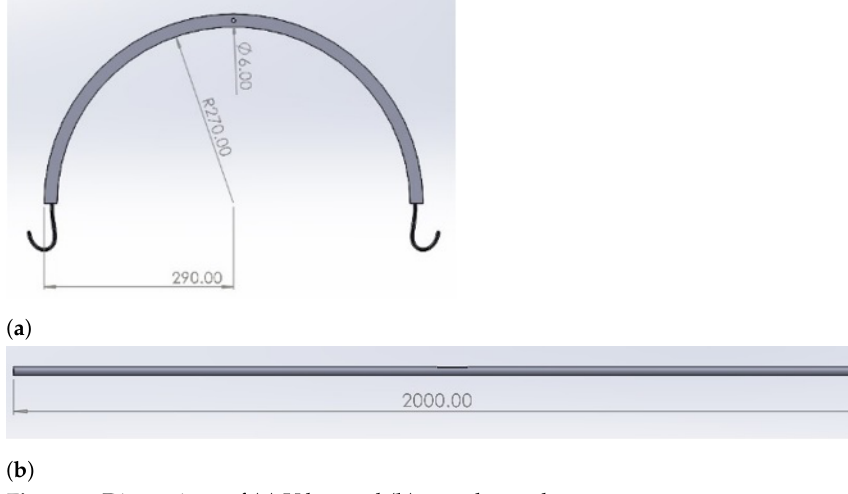
Figure 8. Dimensions of ( a ) U bar and ( b ) stretcher rod. Multiple parts are assembled in Solid works to develop the final CAD assembly. The finalized assembly of the proposed bed is shown in Figure 9.